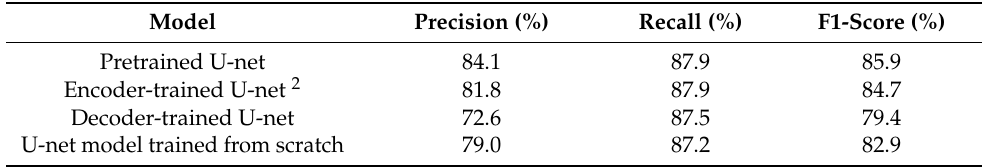
Table 4. Performance metrics of various U-net models on past test dataset (source domain 1 ).